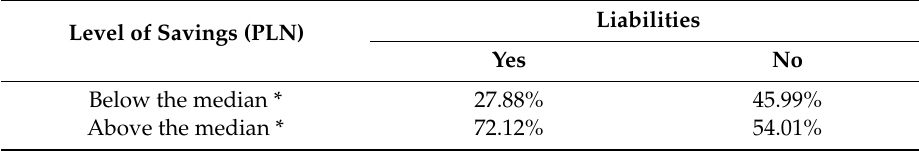
Table 4. Liabilities and the level of savings generated by small farms in Poland. Liabilities Level of Savings (PLN) Yes No Below the median * 27.88% 45.99% Above the median * 72.12%